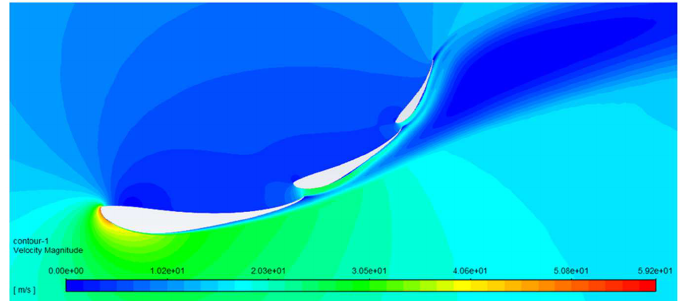
Figure 7. Multi-element profile speed contour